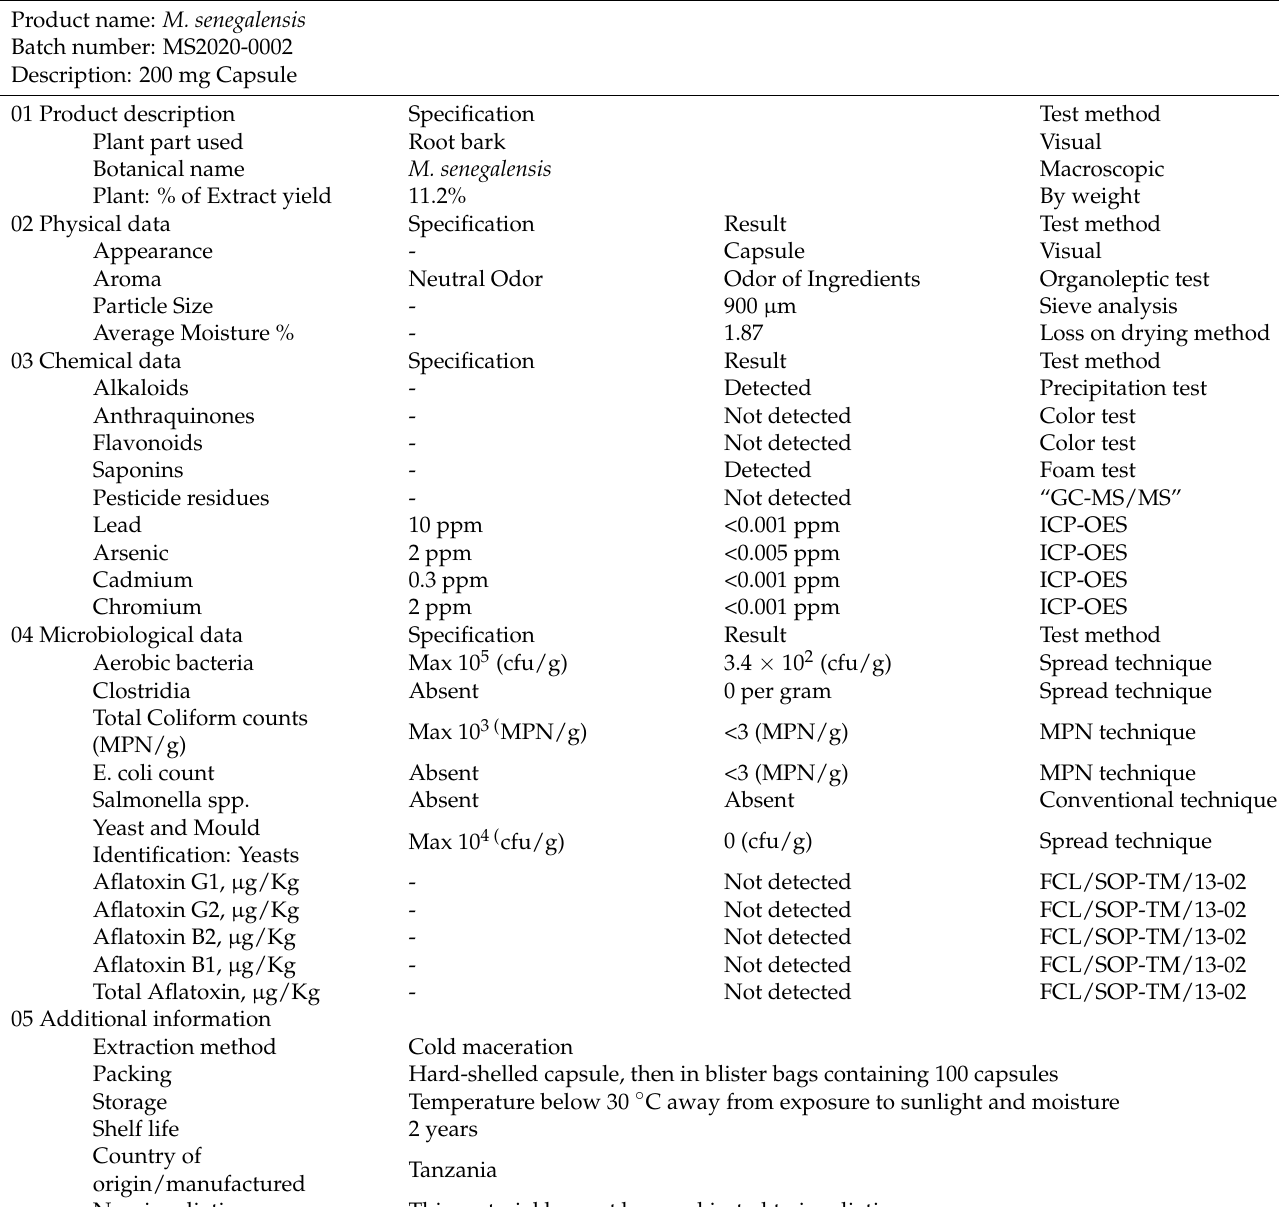
Table 1. Compilation of analysis